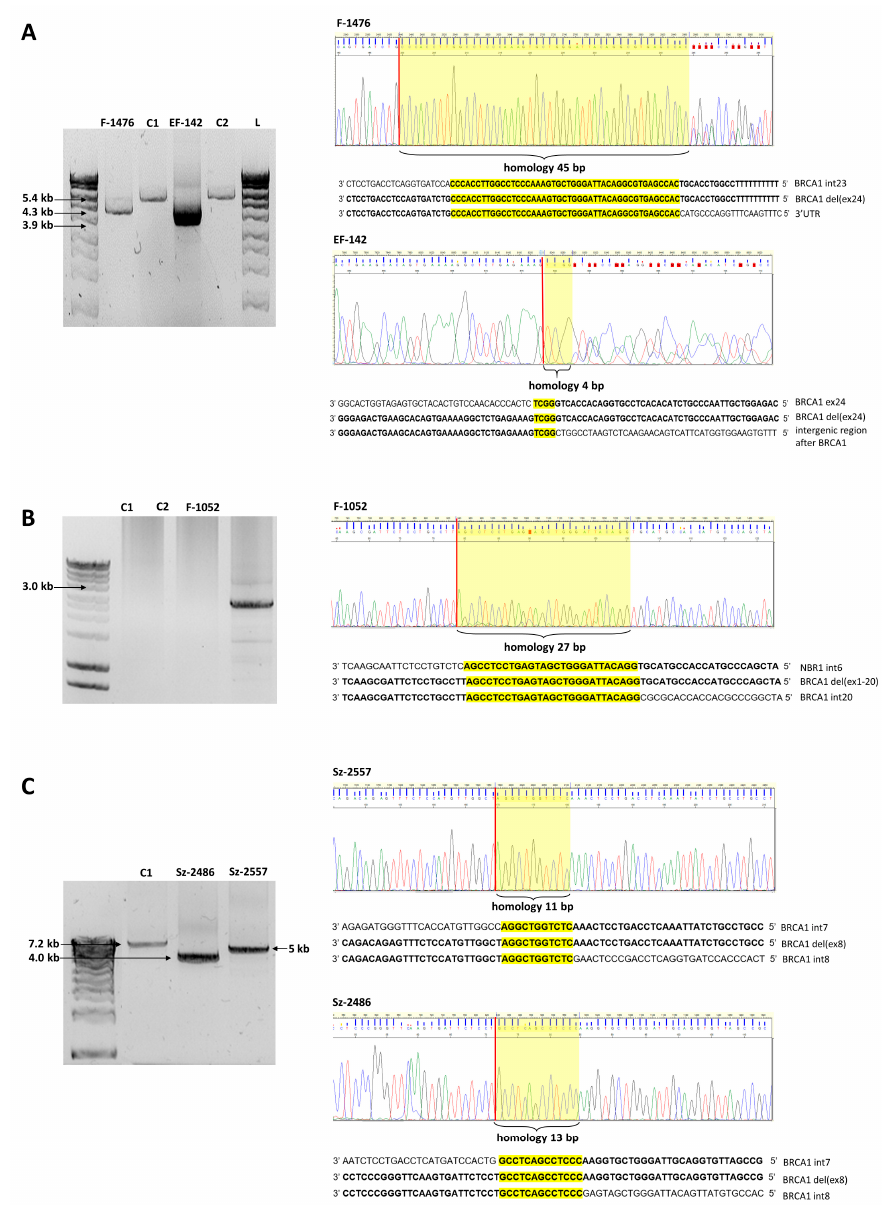
Figure 1. Representative examples of breakpoint determination in three rearrangement types. ( A ): BRCA1 del(ex24) samples, ( B ): BRCA1 del(ex1-20) sample, and ( C ): BRCA1 del(ex8) samples. Upper panels: agarose gel visualization of the junction fragments. Lower panels: breakpoint spanning sequence electropherograms of the junction fragments. L: Hyper Ladder 1 kb DNA sizing standard. C1 and C2 are BRCA1/2 negative control samples. Red bars represent the concerted breakpoints according to the 3’ rule. Yellow boxes highlight the perfect sequence homologies at the breakpoint junctions. Exact base sequences surrounding the breakpoints relative to the reference sequence are shown below the electropherograms. ( A ): F-1476 is a LRG_292t1:c.5468-364_*749del heterozygote sample with 1.1 kb deletion and EF-142 is a LRG_292t1:c.5506_*1383 + 36del heterozygote sample with 1.5 kb deletion. ( B ): F-1052 is a NG_005905.2:g.33502_166230del heterozygote sample with 133 kb deletion. The C1 and C1 samples did not yield PCR product of 136 kb. ( C ): Sz-2486 is a LRG_292t1:c.441 + 1521_547 + 392del heterozygote sample with 3.2 kb deletion and Sz-2557 is a LRG_292t1:c.442-1830_547 + 295del heterozygote sample with 2.2 kb deletion. The wild type alleles of the mutation carrier samples did not yield amplification